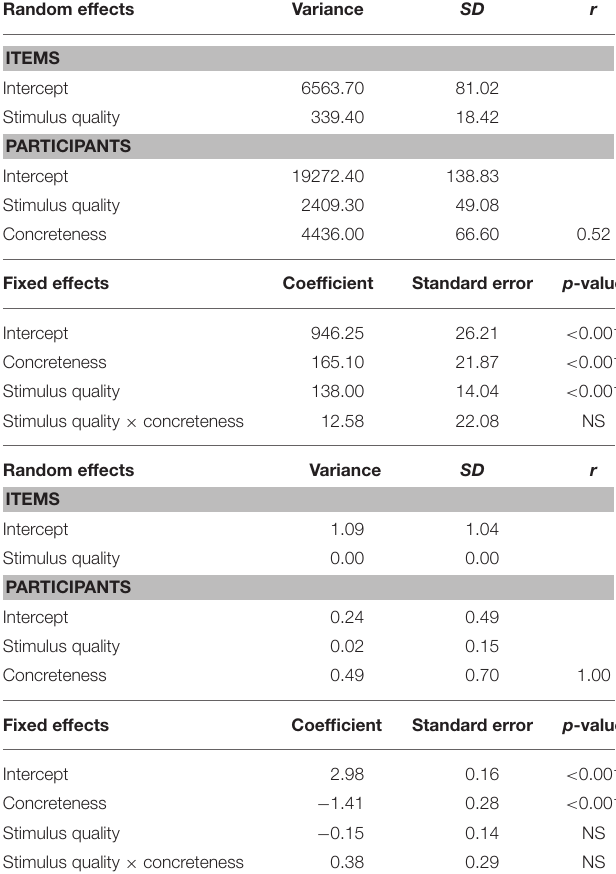
TABLE 3 | LME (top panel: RT) and GLM (bottom panel: Accuracy) model estimates for fixed and random effects for the joint effects of stimulus quality with